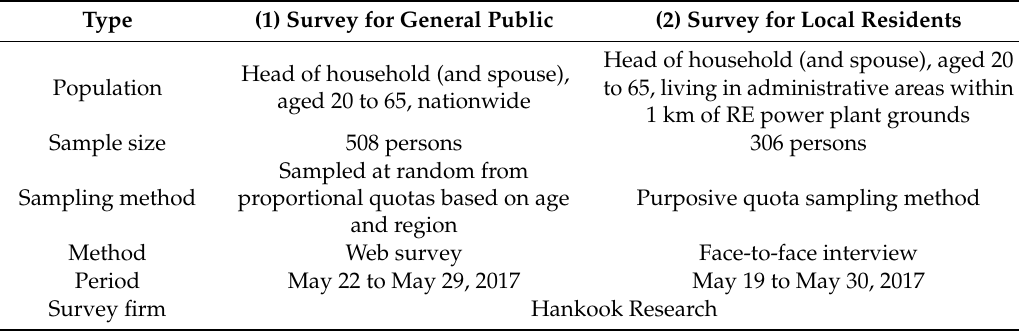
Table 3. Summary of survey design.